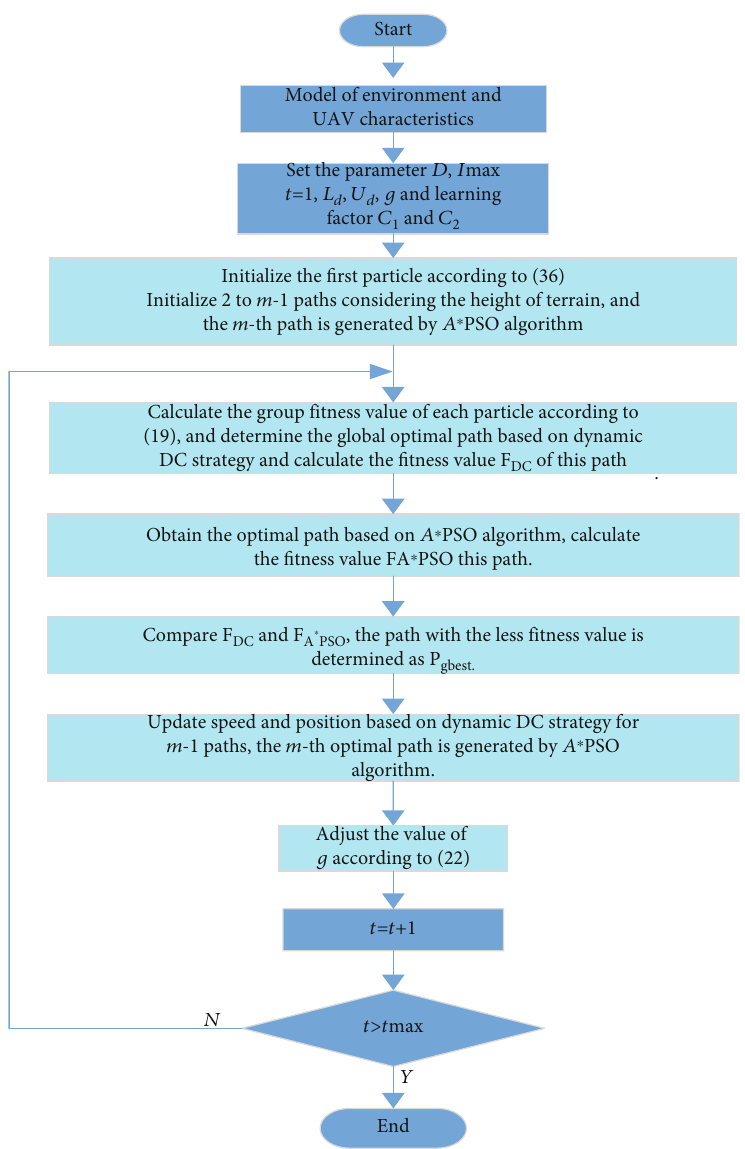
Figure 5: The fl ow chart of the DCA ∗ PSO